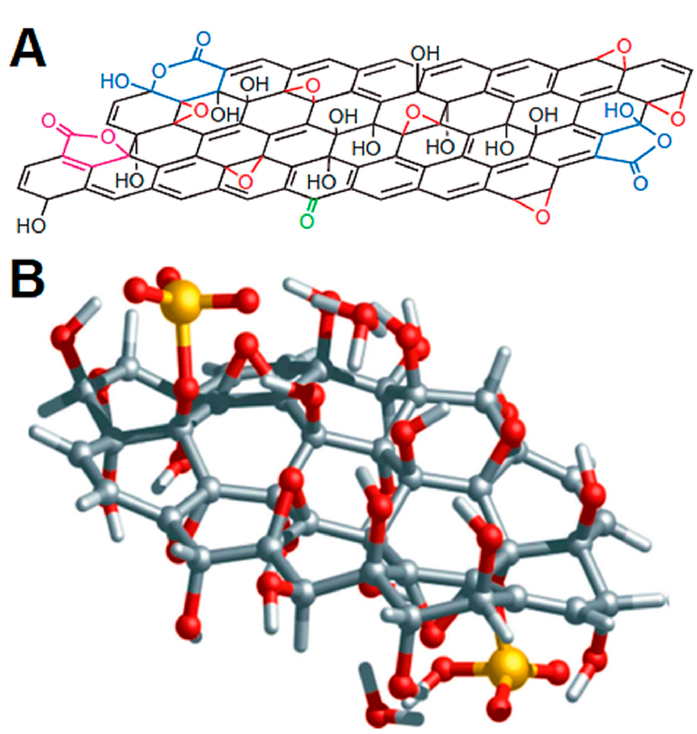
Figure 2. ( A ) Structural model of graphene oxide, taking into account five- and six-membered lactol rings (blue), ester of a tertiary alcohol (purple), hydroxyl (black), epoxy (red), and ketone (green) functionalities. The relative ratios are likely to be 115 (hydroxyl and epoxy): 3 (lactol O–C–O): 63 (graphitic sp2 carbon): 10 (lactol/ester/acid carbonyl): 9 (ketone carbonyl). Reprinted with permission from [30]. 2009, Nature. The model here only shows the chemical connectivity, and not the steric orientation, of these functionalities and ( B ) Structure of graphene oxide with epoxy and hydroxyl as dominant functional groups. Reprinted with permission from [31]. 2013, Wiley.